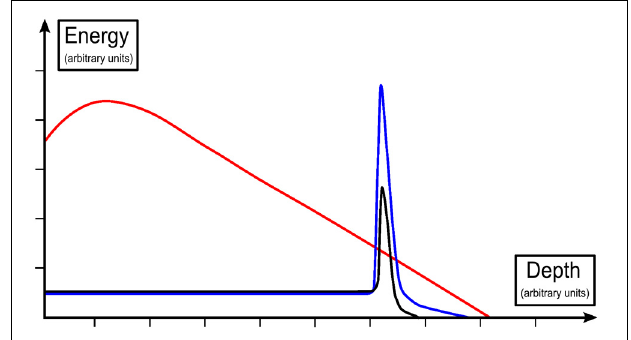
FIGURE 2 | Schematic display of depth dose profiles of a photon (red), proton (black) and antiproton beam (blue), with deposited energy expressed relative to the plateau region [19,